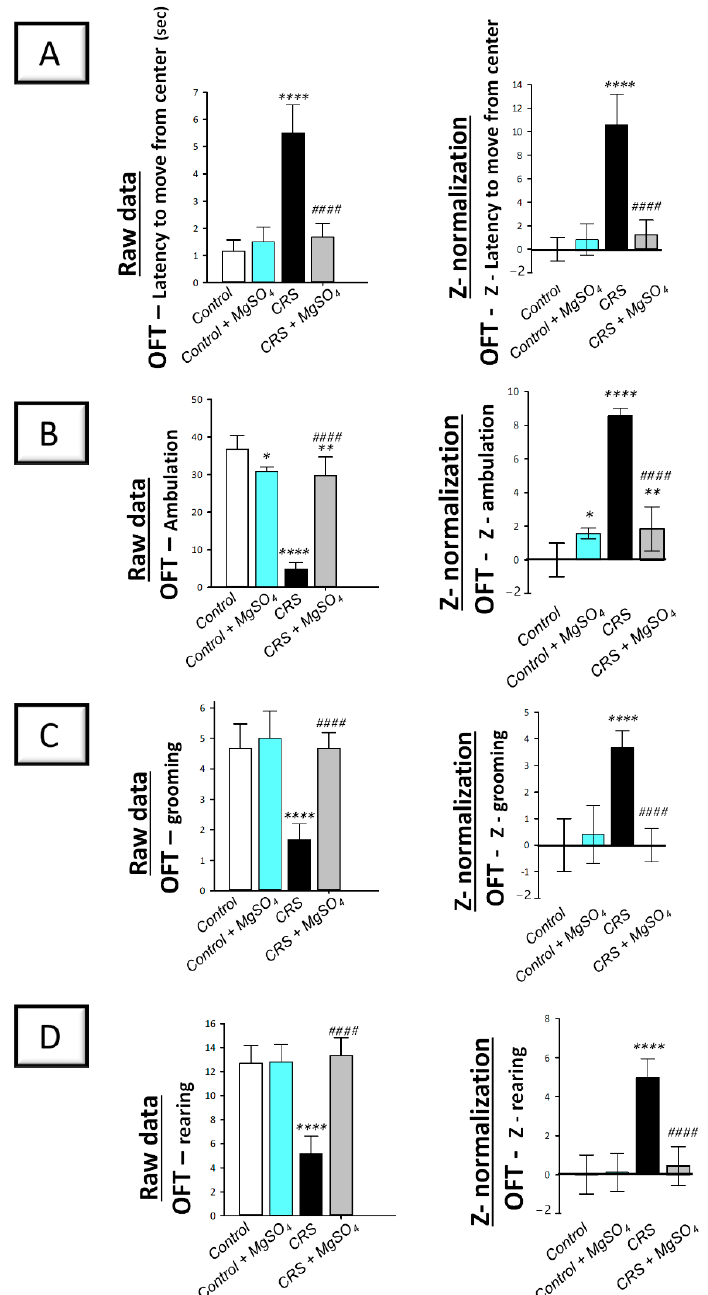
Figure 3. Effect of magnesium sulfate on the depression-like behavioral changes triggered by chronic restraint stress (CRS) in the open field test (OFT) in rats. Administration of magnesium sulfate attenuated the depression-associated decline in locomotor activity that was invoked by CRS. The beneficial effects of magnesium sulfate were demonstrated by the decreased latency time to move from the center [F (3, 20) = 54.39, p < 0.0001] ( A ) alongside the increased ambulation [F (3, 20) = 114.2, p < 0.0001] ( B ), grooming [F (3, 20) = 29.33, p < 0.0001] ( C ), and rearing [F (3, 20) = 41.15, p < 0.0001] ( D ) in the OFT. Calculation of Z-values was described in the material and methods Section 4.5.4. using the control group as the baseline. Z-values are expressed as the mean of 6 Z-scores ± standard deviation (S.D.). Statistical analysis was applied using one-way ANOVA followed by Tukey’s post-hoc test. Significant differences versus control animals are denoted by * p < 0.05, ** p < 0.01, or **** p < 0.001. Significant differences versus CRS group are denoted by # ### p < 0.001. CRS, chronic restraint stress; MgSO 4 , magnesium sulfate.